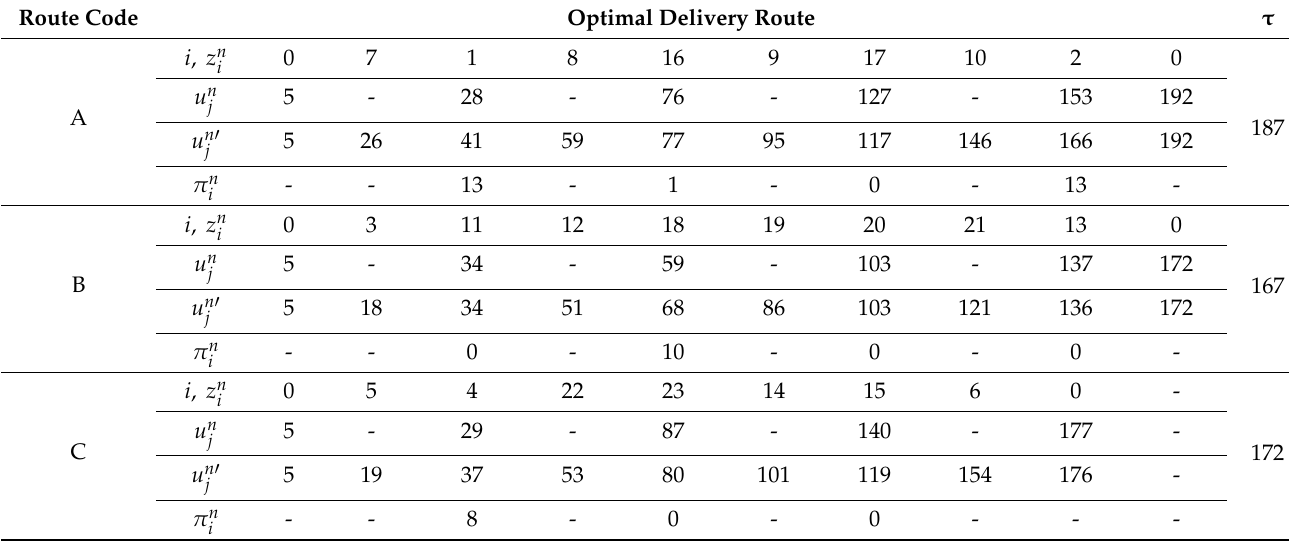
Table 2. Optimal delivery route and total delivery time of each